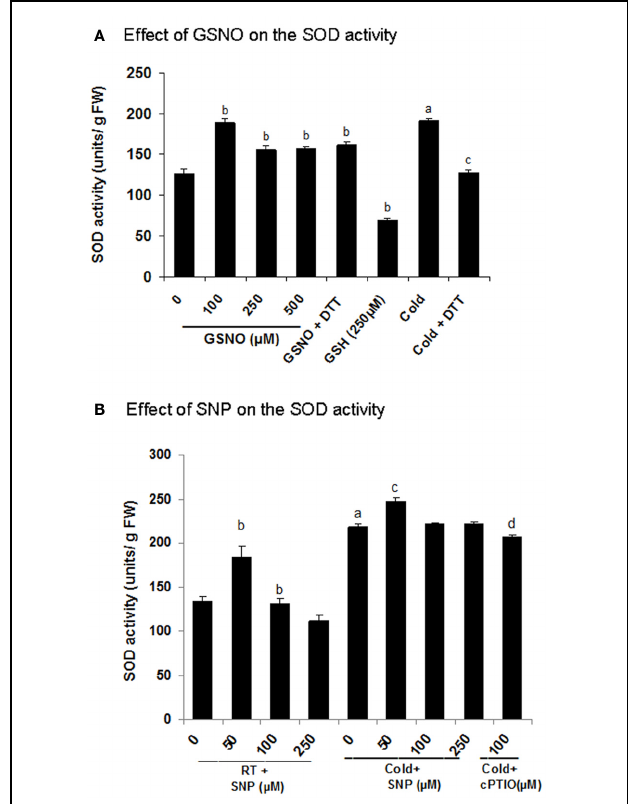
FIGURE 7 | Functional validation of superoxide dimutase (SOD) as a cold responsive S-nitrosylated protein. (A,B) Effect of GSNO and SNP on the SOD activity measured using NBT reduction assay. For the in vitro assays, extracts were incubated with or without GSNO (100 µ M, 250 µ M and 500 µ M) or GSH (250 µ M) prior to the activity analysis. Incubation with DTT (10mM) was also done after GSNO (100 µ M) treatment to check the reversal. Seedlings were treated with SNP (50–250 µ M) and cPTIO (100 µ M) with or without cold stress. Extracts from these samples were used for the assay. Error bars represents standard deviation from three independent experiments (biological repeats) performed in triplicates (technical repeats). Statistical significance was determined by Student’s t -test. In (A) statistically significant difference ( p < 0 . 05) between RT (control) and cold is shown (by a), control and GSNO (by b) and cold and DTT (by c). In (B) values with the same alphabets are showing significant difference ( p < 0 . 05) between RT and cold (by a), control and SNP (by b), cold and SNP (by c) and cold and cPTIO (by